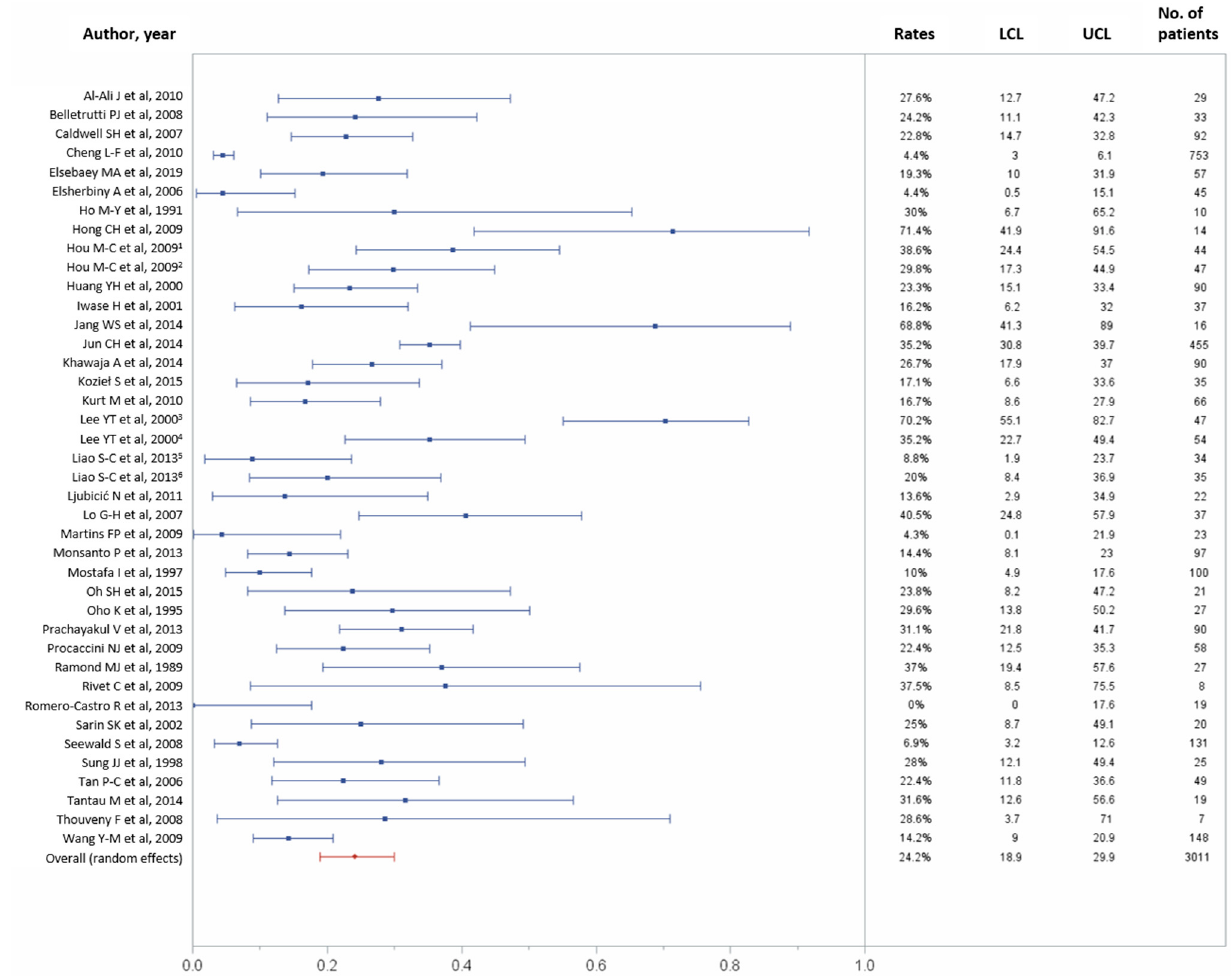
Figure 3. Forest plot of the 30-day rebleeding rate. Overall rate (random effects model): 24.2% (95% CI, 18.9–29.9%); heterogeneity: Q = 434.05, p < 0.0001, I² = 91.01%; UCL, upper control limit; LCL, lower control limit; No, number.